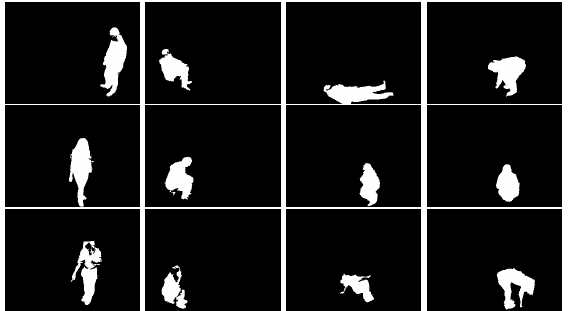
Figure 9. Posture Samples from Dataset D1. Column 1, 2, 3 and column 4 correspond to Standing, Siting, lying and Bending postures